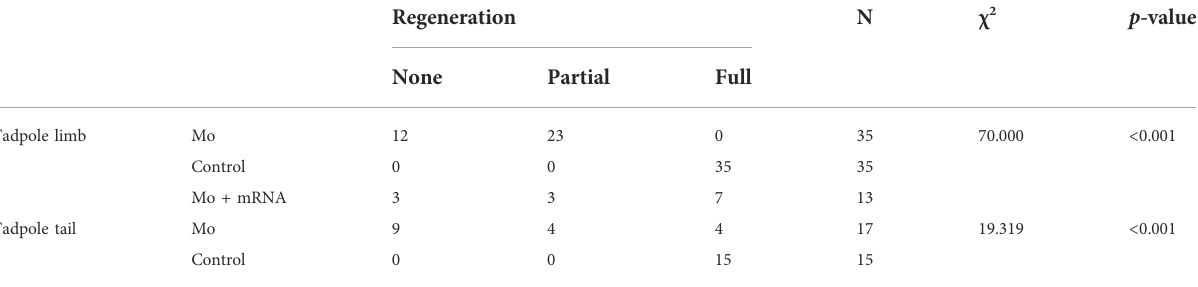
Table notes: Regeneration of the limb and tail were determined by morphology of the regenerates described in material and method section. Chi-square test was used for signi fi cance analysis for Mo vs. Control.